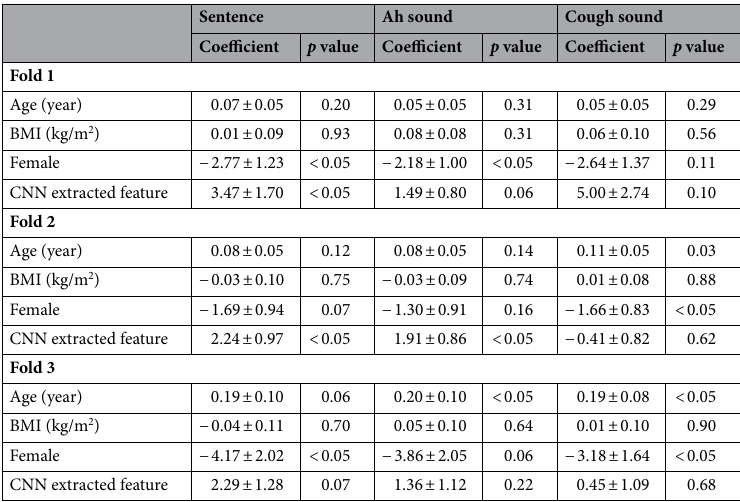
Table 5. Association of the convolutional neural network’s (CNN) extracted features for various voice types and recent COVID-19 after controlling for age, BMI and